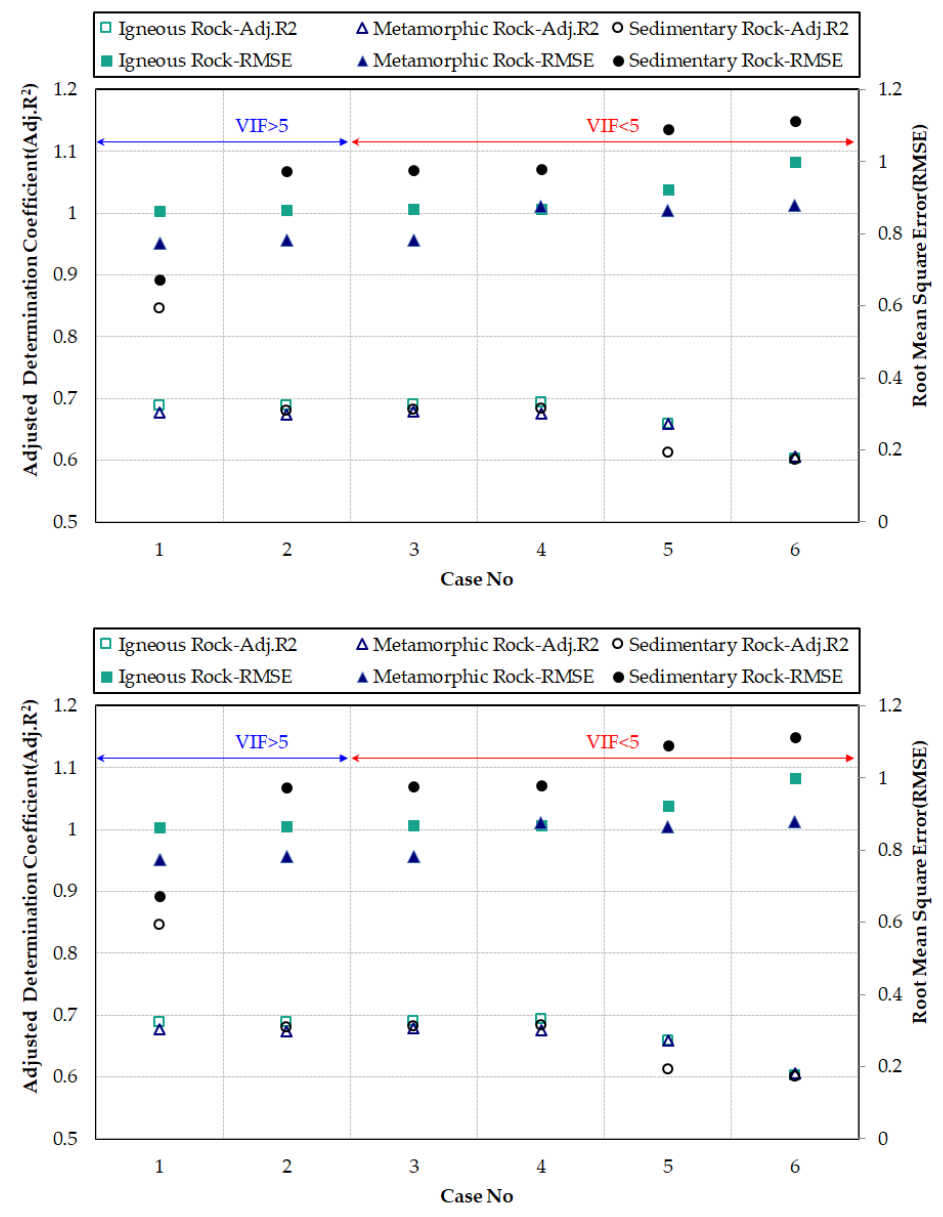
Figure 6. Comparison results of six regression models for selecting suitable Figure 6 . Comparison results of six regression models for selecting suitable models.